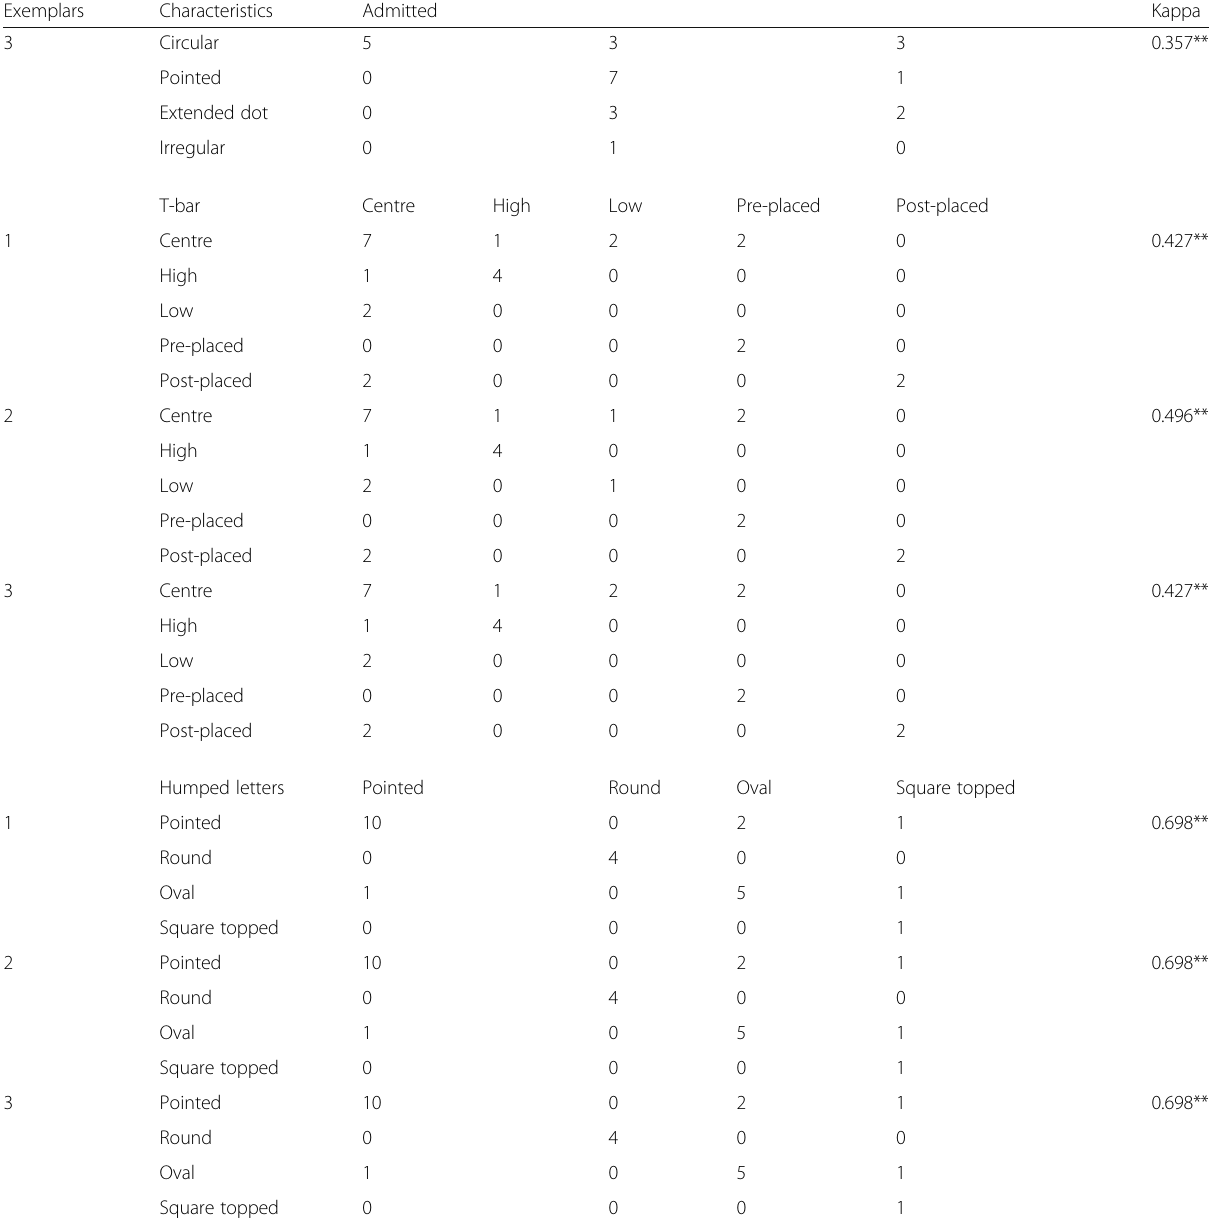
Table 3 Cohen ’ s kappa coefficient showing the agreement in characteristics between the admitted and the three exemplars (Continued) Exemplars